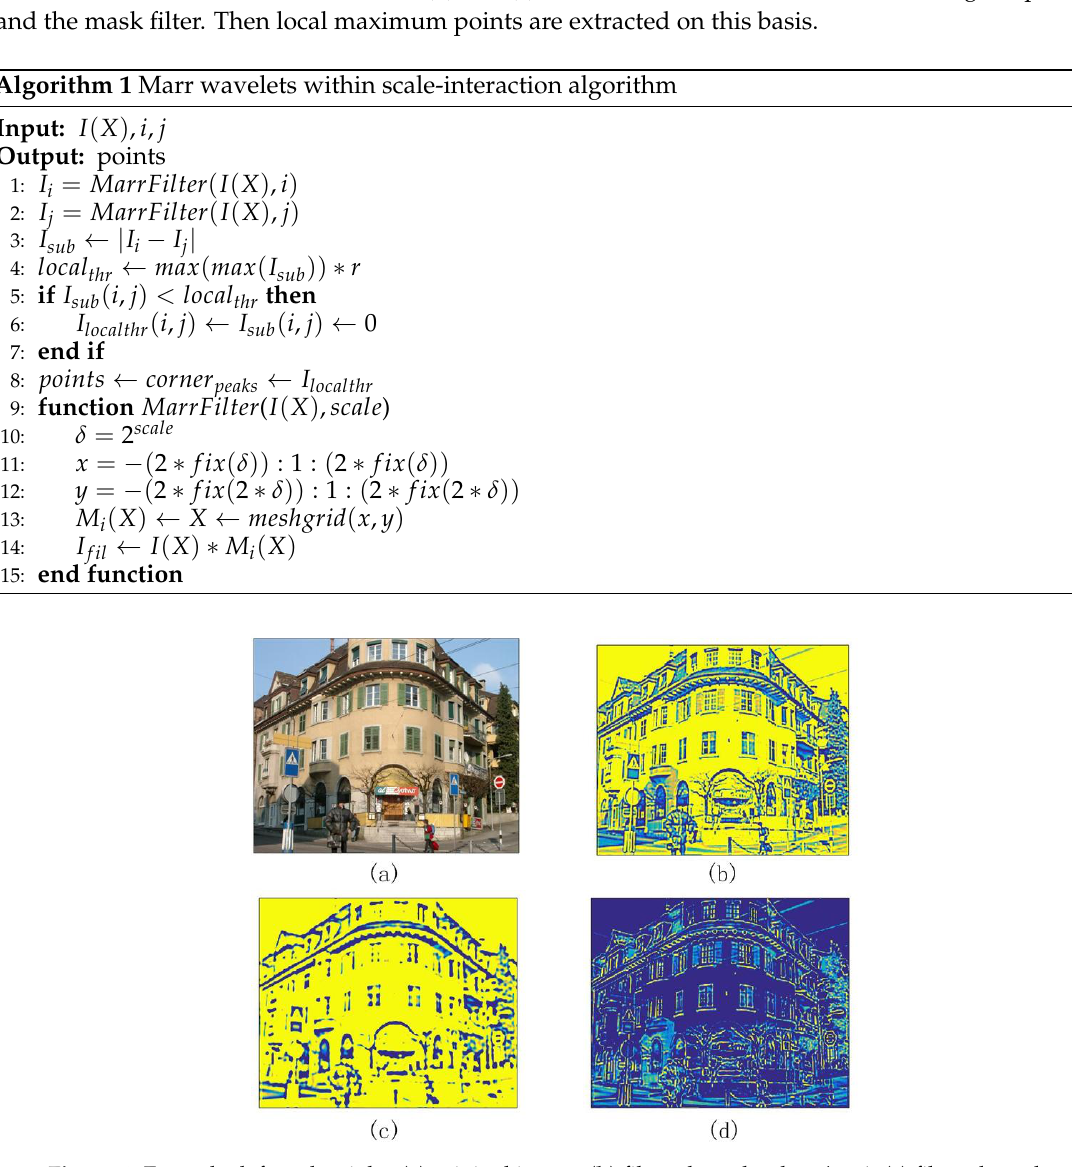
Figure 4. From the left to the right: ( a ) original image, ( b ) filtered result when i = 1, ( c ) filtered result when i = 2 and ( d ) response